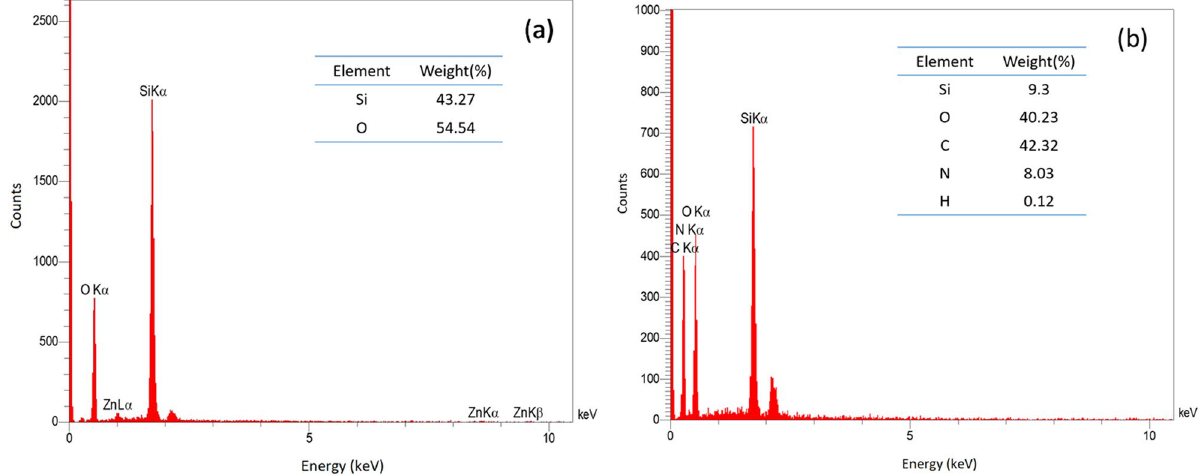
Figure 4. The EDX spectrum of nanosphere (a) KCC-1 and (b) KCC-1@NH 2 .